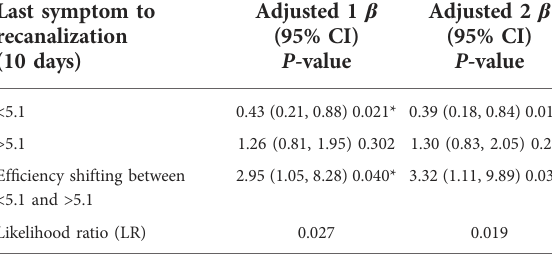
TABLE 5 Threshold effect analysis of the time from the last symptom to operation on successful